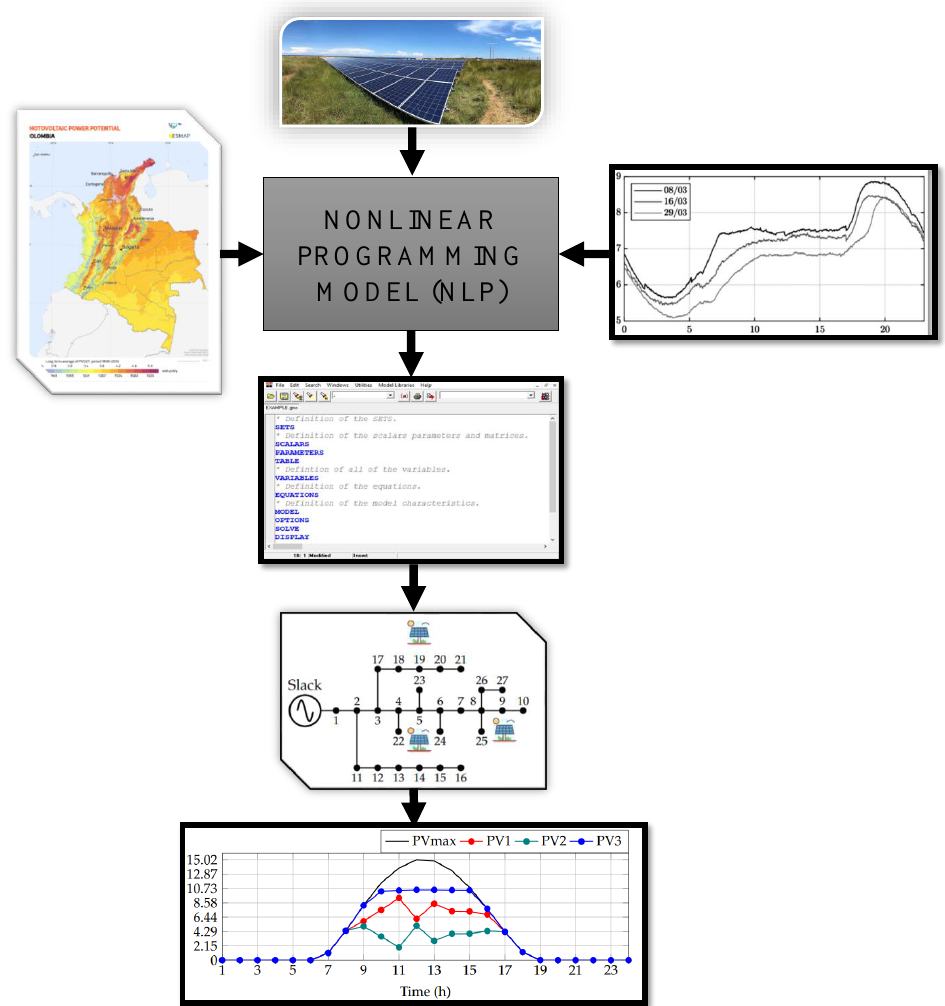
Figure 1. Main aspects of the proposed solution